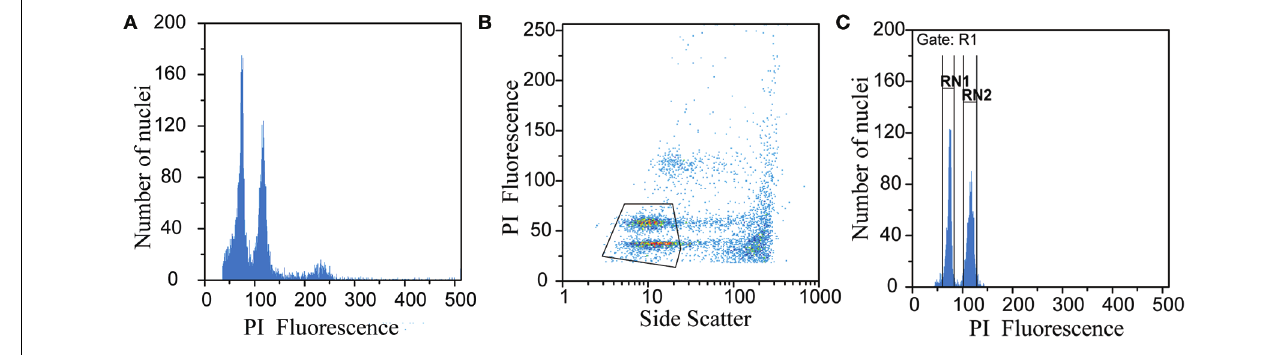
FIGURE 1 | An example of the gating procedure using data from Primulina linearifolia . Ungated histogram (A) , scatterplot with manually drawn polygon gate (B) , histogram with polygon gate applied